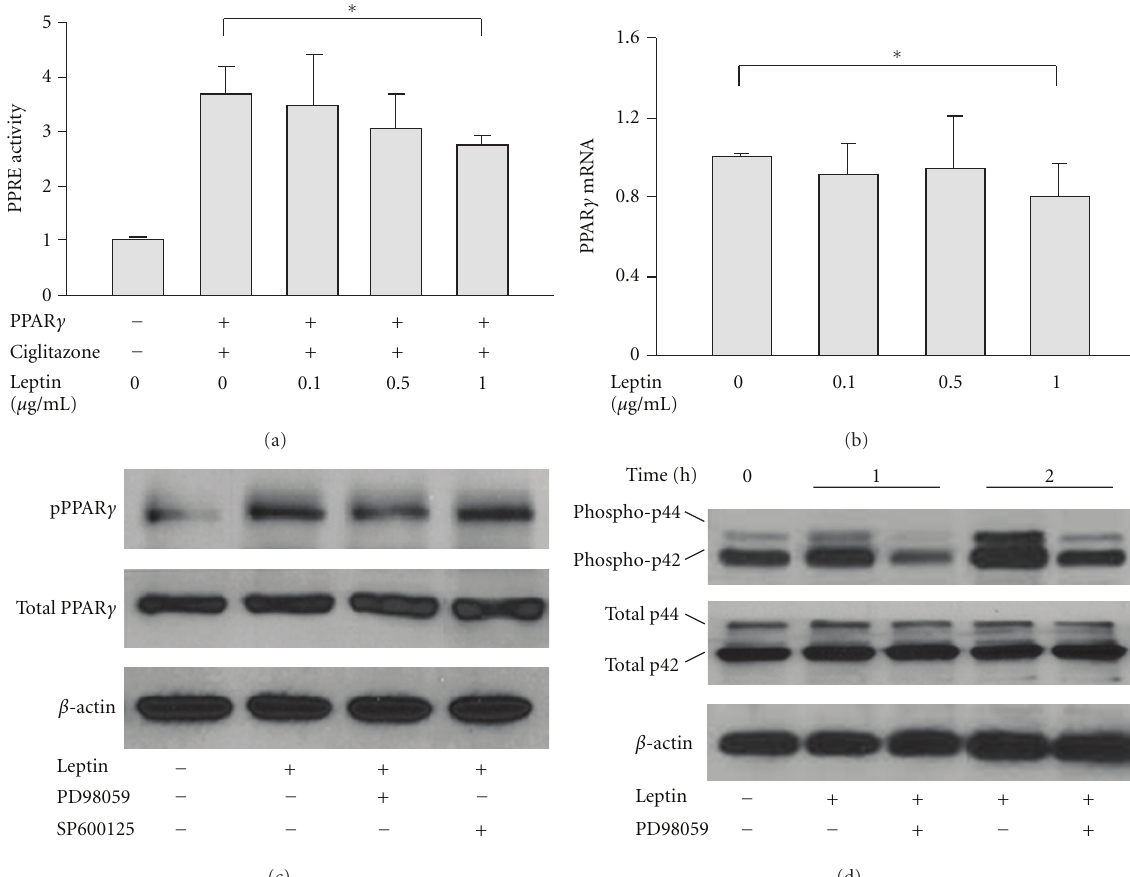
Figure 2: Leptin inhibits PPAR γ signaling in growth plate chondrocytes by enhancing PPAR γ phosphorylation via MAPK/ERK pathway. (a) PPAR γ -mediated PPRE transcriptional activity in chondrocytes treated with leptin at a concentration ranged from 0.1 to 1 μ g/mL. ∗ P < 0 . 05 versus the samples untreated with leptin. (b) PPAR γ mRNA expression of growth plate chondrocytes in response to leptin treatment. (c) Immunoblotting analysis of the levels of total and phosphorylated (Ser112/82) PPAR γ protein in chondrocytes treated with leptin for 2 h. For ERK or JNK inhibition experiments, the cells were preincubated with PD98059 or SP600125 for 30min before leptin treatment. (d) Expression of total and phosphorylated ERK proteins (ERK1/2) in growth plate chondrocytes treated with leptin for 1h and